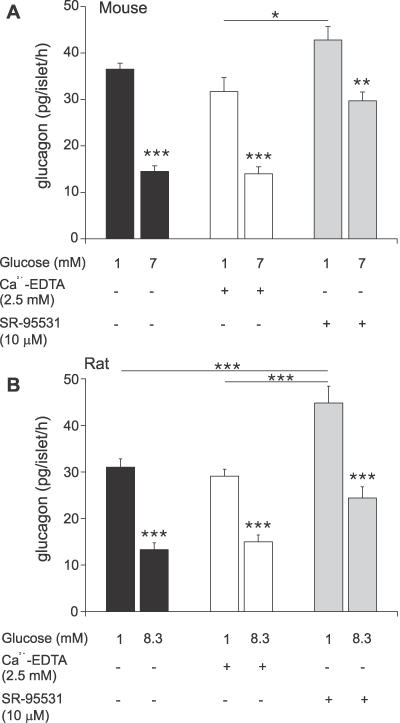
Glucose Suppresses Glucagon Release Independently of Paracrine Signals Mediated by Zn2+ or GABA.(A) Glucagon release from isolated mouse islets was suppressed by 60% at 7 mM glucose compared with 1 mM (filled bars). Glucose retained its suppressive effect on glucagon release under conditions of Zn2+ chelation (Ca2+-EDTA) (open bars) and antagonism of GABAA receptors (SR-95531) (shaded bars). Antagonism of GABAA receptors increased both basal and glucose-suppressed glucagon secretion, suggesting a paracrine role for GABA independent of the glucose effect.(B) As in (A), but using rat islets.
*, p < 0.05; **, p < 0.01; ***, p < 0.001, compared with 1 mM glucose, or as indicated.